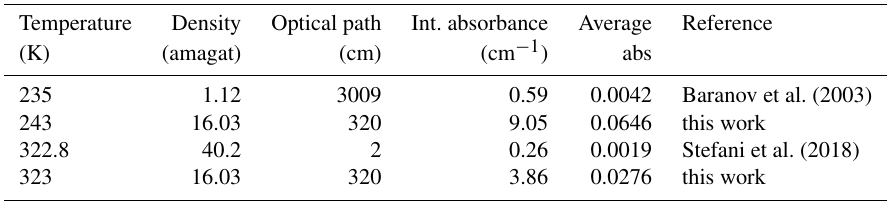
Table 3. The table displays the experimental conditions for the CIA band at 2670cm − 1 as well as the calculated integrated absorbance and average